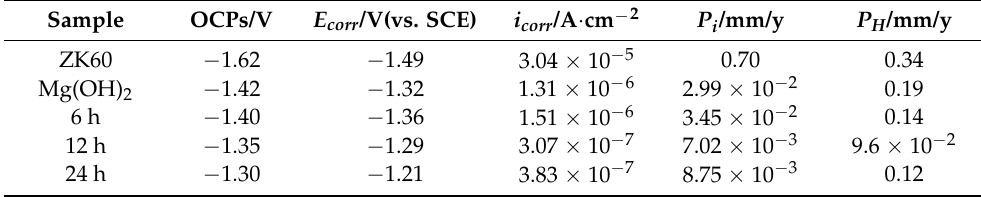
Table 2. The corrosion potential ( E corr ) and corrosion current density ( i corr ) of samples.